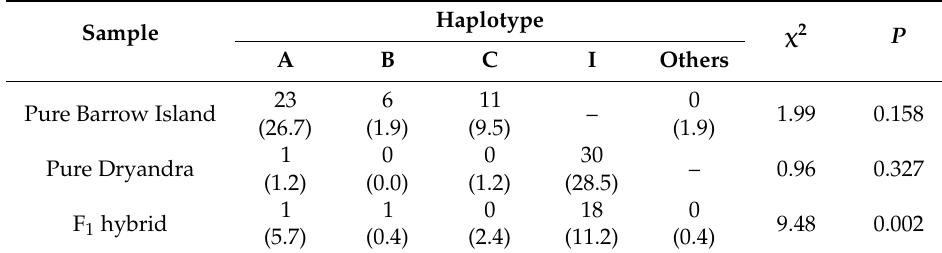
Table 4. Observed and expected numbers of haplotypes in individuals born at the Matuwa translocation site. Individuals were classified as pure Barrow Island, pure Dryandra, or F 1 hybrid, based on the results from the NEWHYBRIDS analysis. Expected numbers for each haplotype were based on the haplotype frequencies and the number of females translocated from each source populations after females with known or assumed mortality were removed. Haplotypes with low expected numbers were pooled prior to carrying out the chi-squared test. Haplotype Sample χ